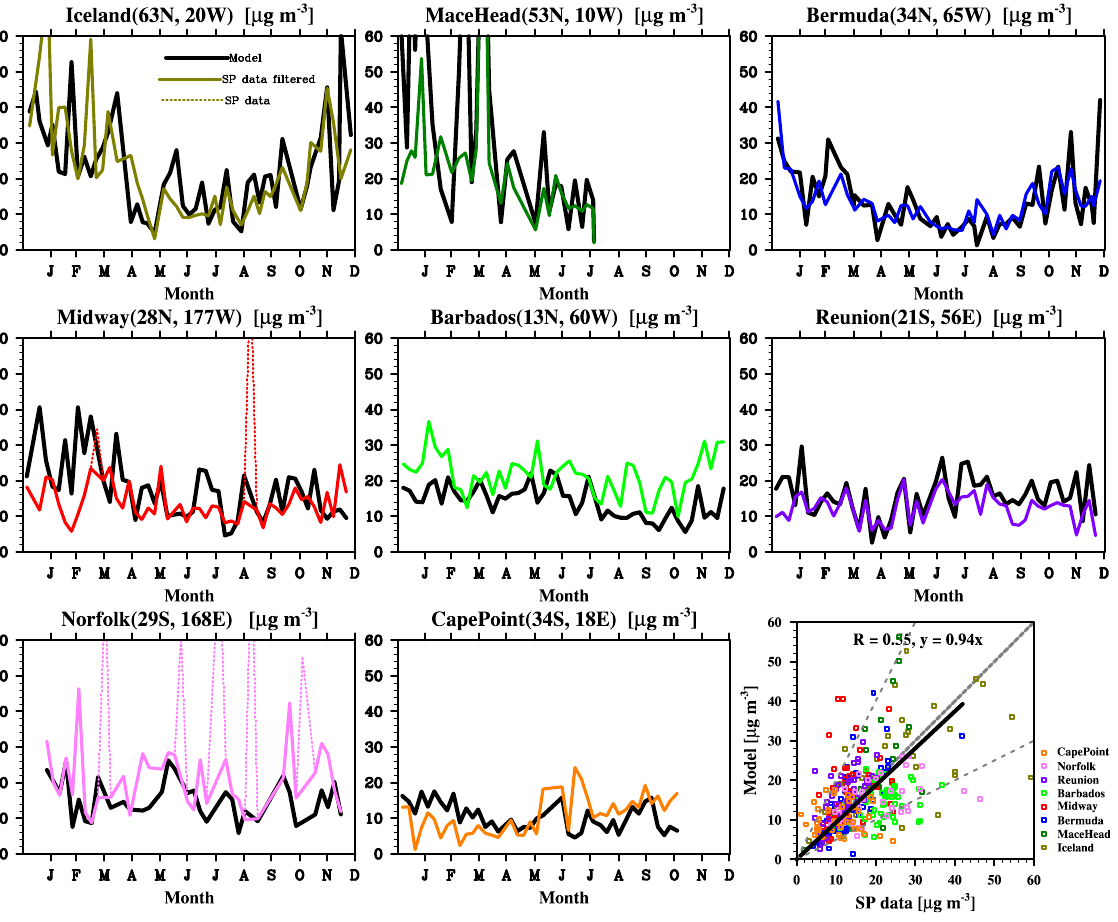
Fig. 6. Seasonal variations and scatter plot of mass concentrations in the marine boundary layer comparing the model results to the mea- surements at eight coastal sites by the University of Miami global network (SP data, Savoie and Prospero, 1977) in 1994. We used the CMS source function with a solubility factor of 0.5. The solid line in the scatter plot is the total linear fit to all the data. The grey short dash line is the one-to-one line and the grey long dashed lines are the one-to-two and two-to-one lines.